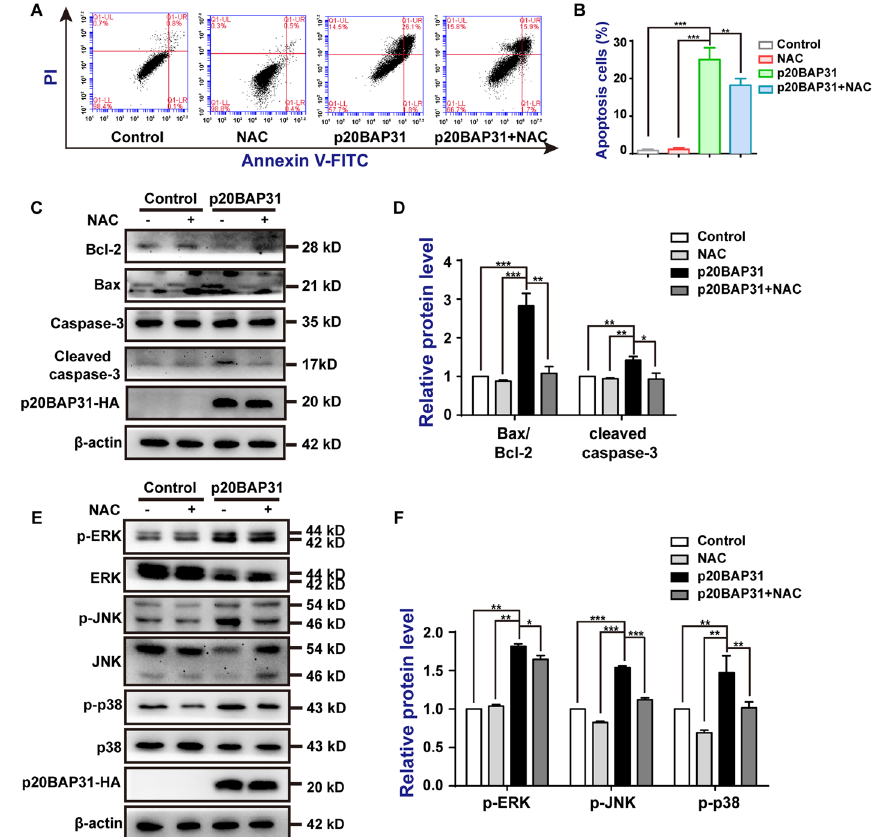
Fig. 5 Roles of ROS generation in apoptosis induced by p20BAP31. Cells were transfected with p20BAP31 for 48 h, with or without pretreatment, with 5 mM NAC for 2 h. A Apoptosis of cells was assessed by flow cytometry analyses of annexin V-FITC/PI double-staining after treatment. B Quantitative analysis of apoptosis rates by flow cytometry. C The protein expression levels of Bcl-2, Bax, caspase-3, and cleaved caspase-3 in HCT116 cells were determined by western blotting. D Relative quantities analysis of Bax/Bcl-2 and cleaved caspase-3 in HCT116 cells. E Western blotting was used to detect p-ERK, ERK, p-JNK, JNK, p-p38, and p38 levels in HCT116 cells. F Relative quantities analysis of p-ERK, p-JNK, and p-p38 in HCT116 cells. * P < 0.05, ** P < 0.01 and *** P <